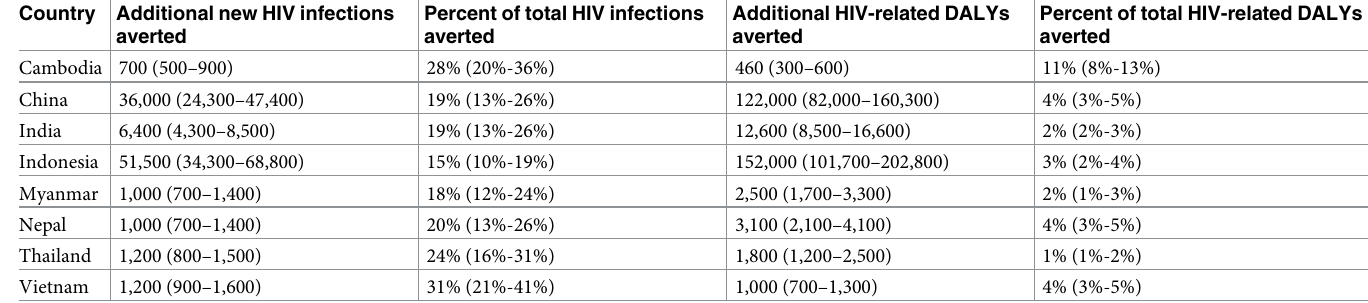
Table 2. Estimated additional new HIV infections and HIV-related DALYs averted by 2031 through PrEP coverage of 15% of MSM from 2022 to 2026 (range of 10% to 20% PrEP coverage).